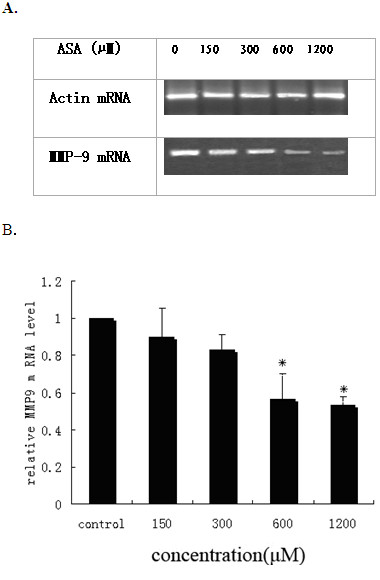
ASA inhibition of MMP-9 expressions in THP-1 derived macrophages. Macrophages were cultured in medium containing 10% FBS and different concentrations of ASA for 24 h. Total RNAs were isolated and mRNA levels for MMP-9 and Actin genes were examined by RT-PCR analysis. Amplified cDNA products were applied to 1.5% agarose gels, stained with ethidium bromide and visualized under a UV light (A). The signal intensities from gels were qualified by the Quantity One software and transformed to the bar graph (B). Results are expressed as mean ±S.D, of three experiments with duplicated samples. * P < 0.05,compared to control.